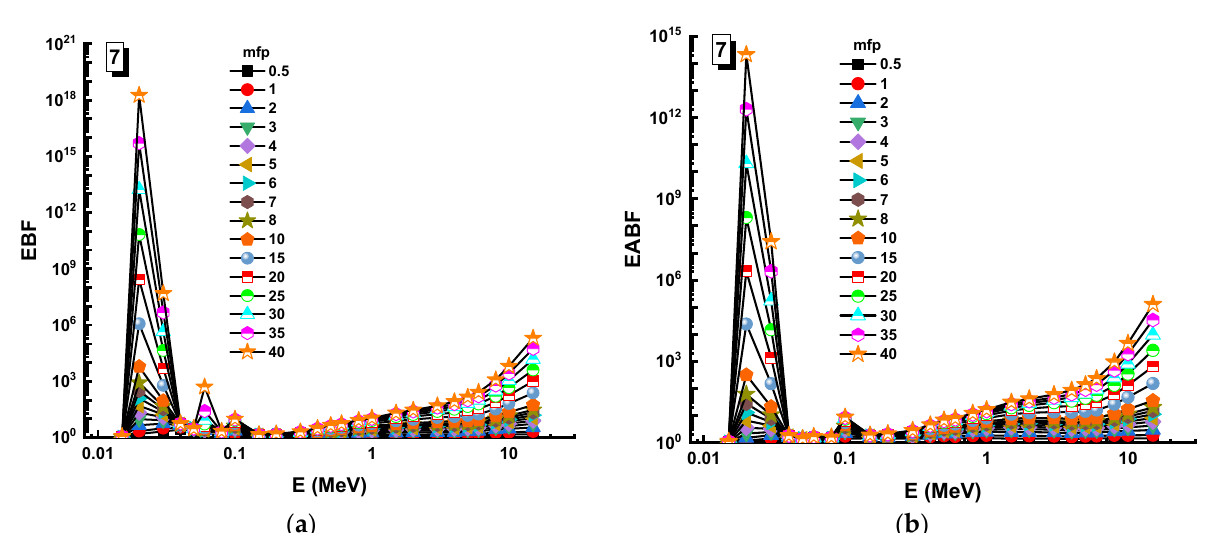
Figure 14. Variation of ( a ) EBF and ( b ) EABF against photon energy for Sample 7.